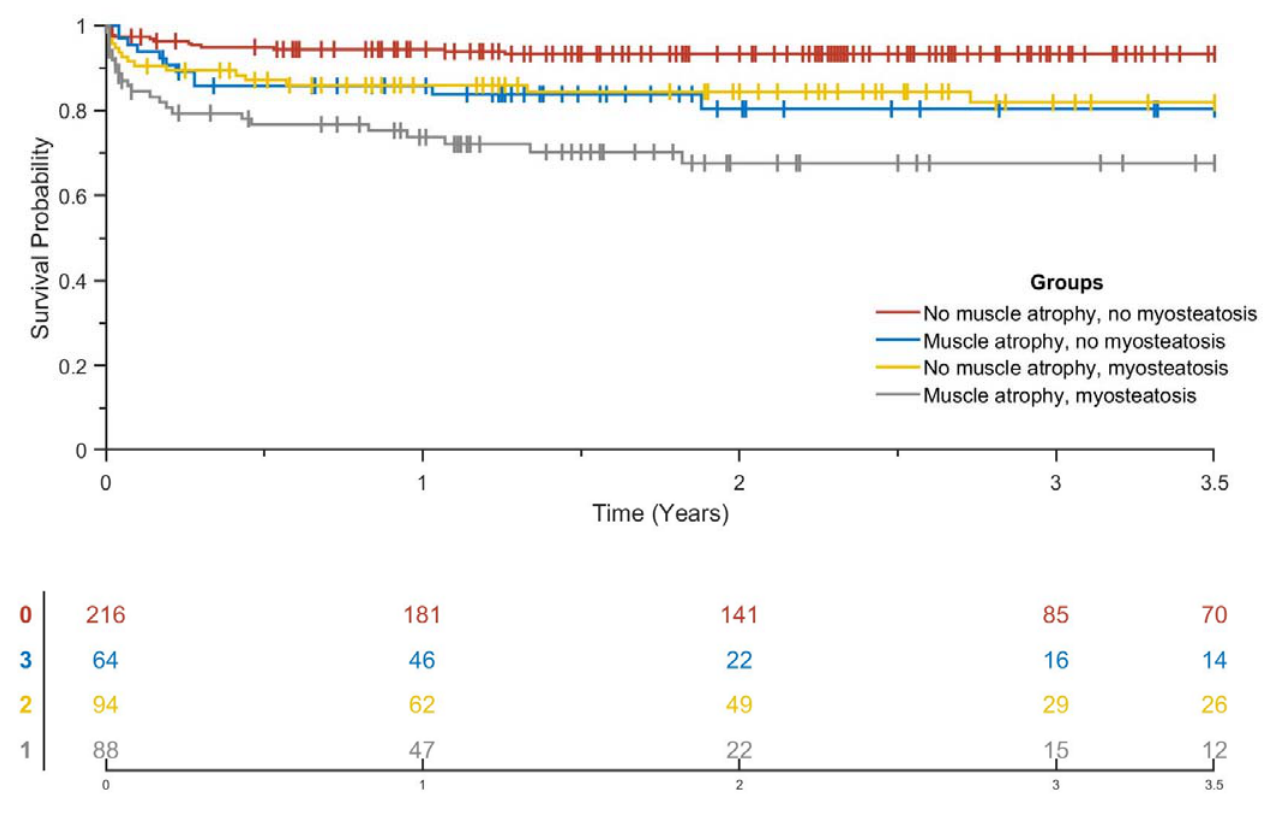
Figure 3. Kaplan–Meier amputation-free survival curves of patients with or without different forms of muscle depletion.